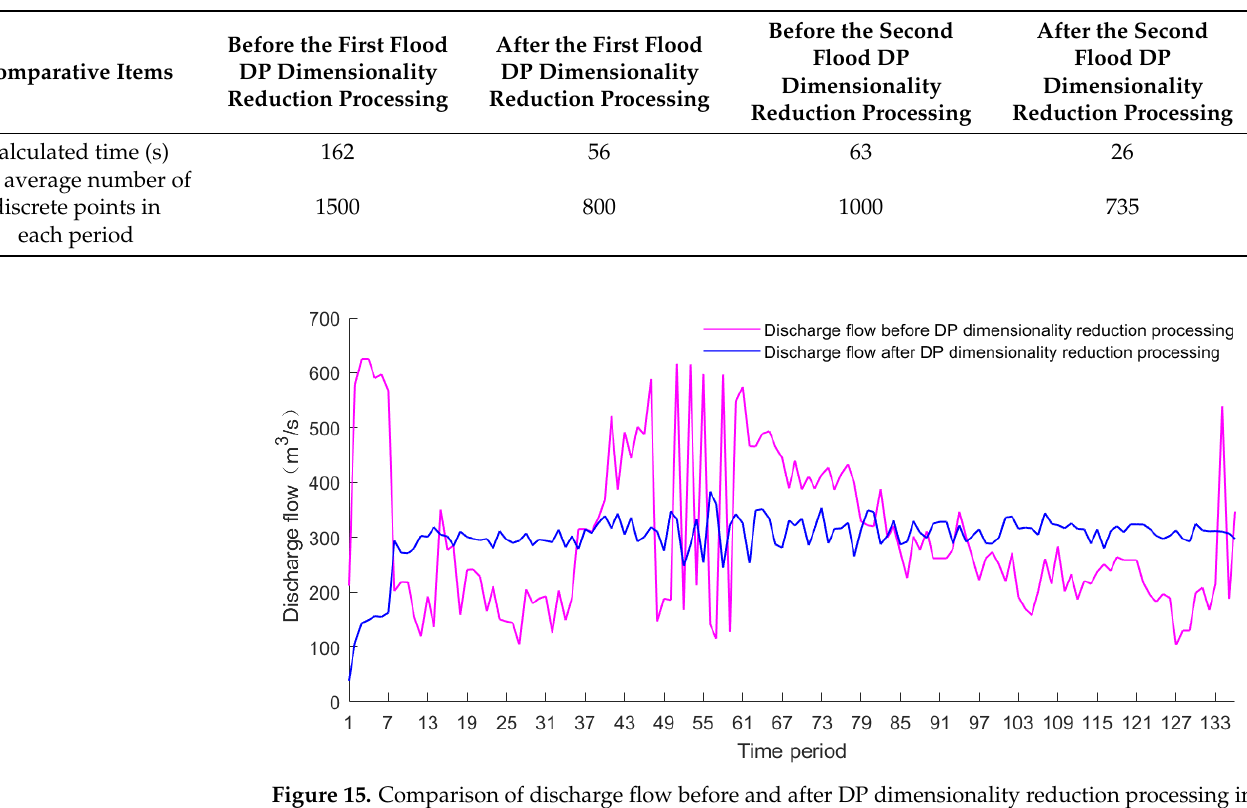
Table 1. Comparison of results before and after dimensionality reduction of the maximum peak clipping criterion.